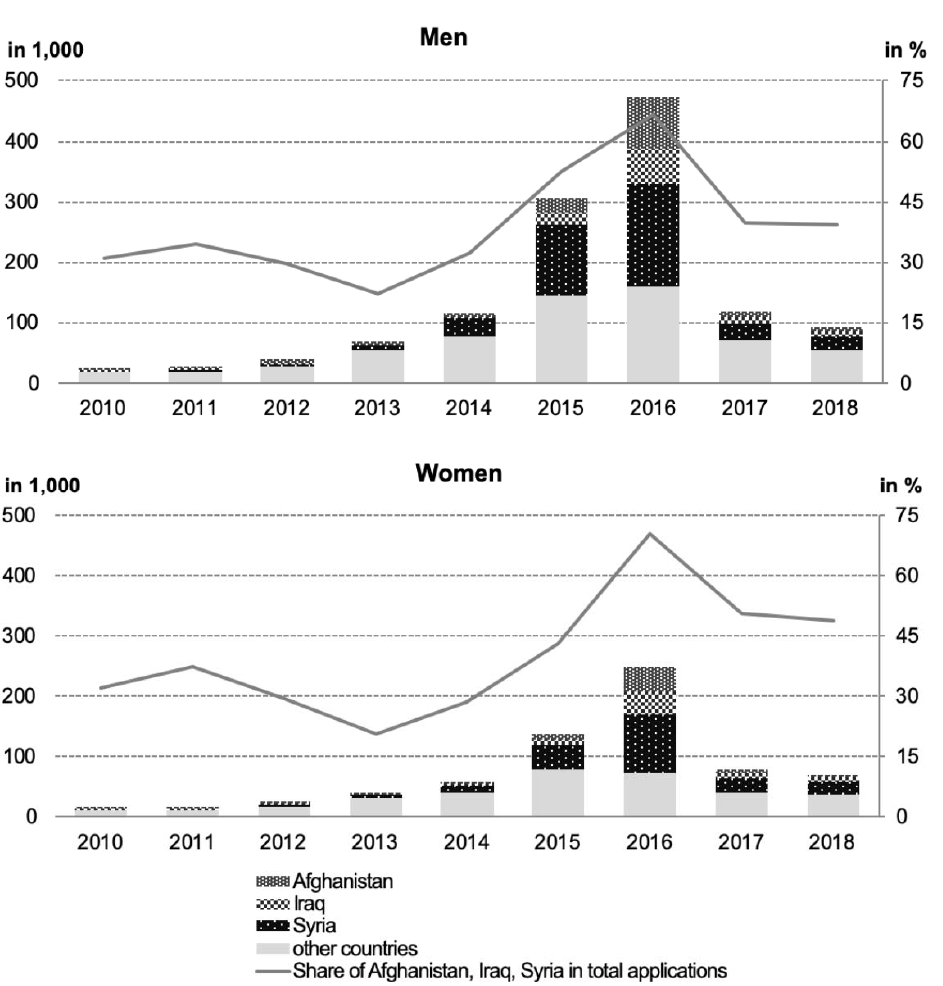
Figure 1 : First-time asylum applications in Germany by sex and country of origin,